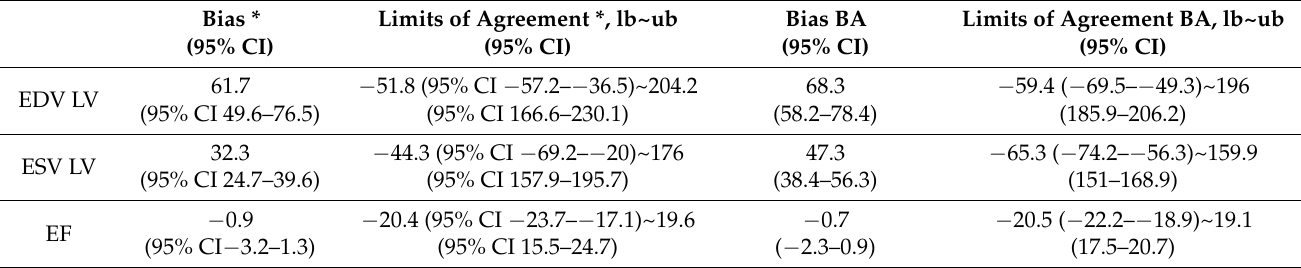
Table 2. Bias, limits of agreement and correlation between CMR and